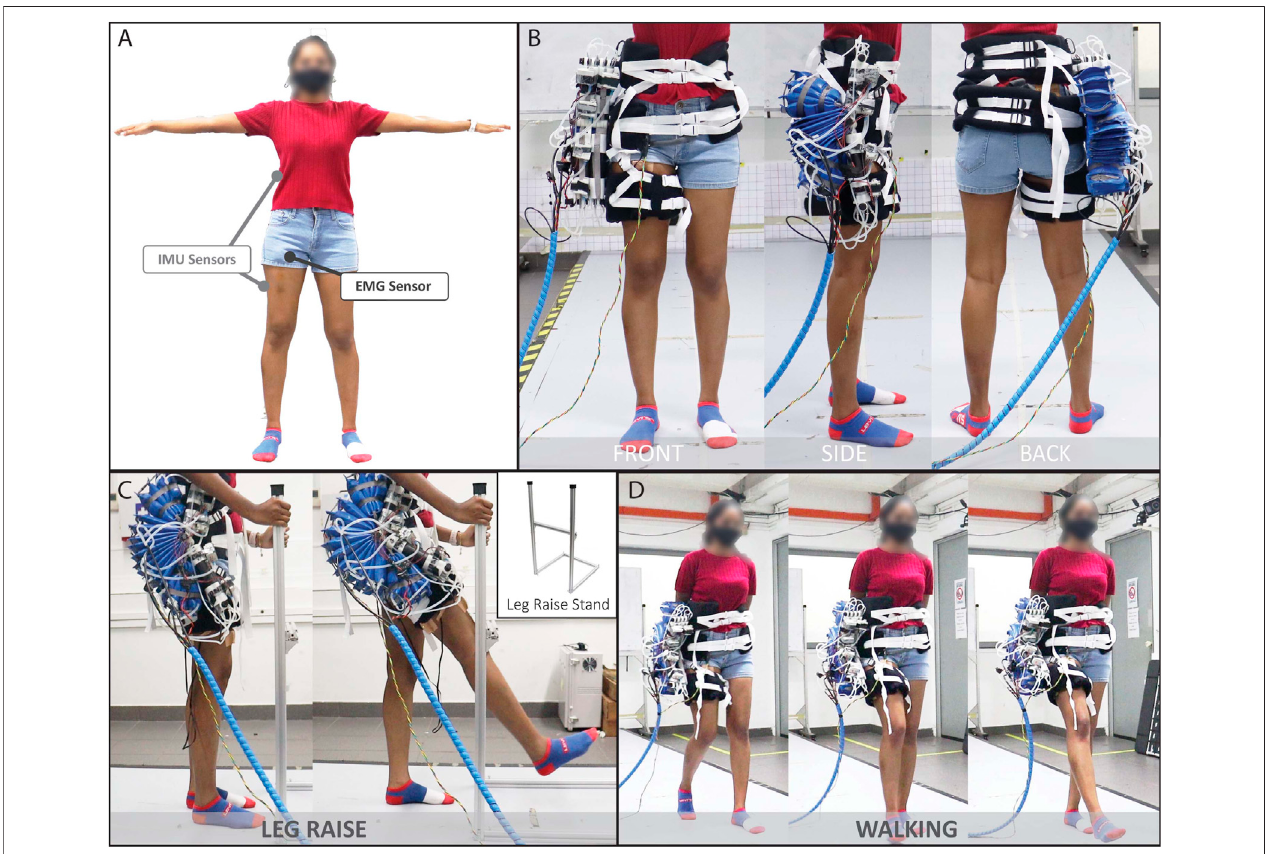
FIGURE 5 | Human Subject Testing: (A) Approximate IMU sensor and EMG sensor placements, (B) Front, side and back views of the subject wearing the device (C) Example of subject performing the Leg Raise motion and (D) Walking motion, both in the assisted condition.